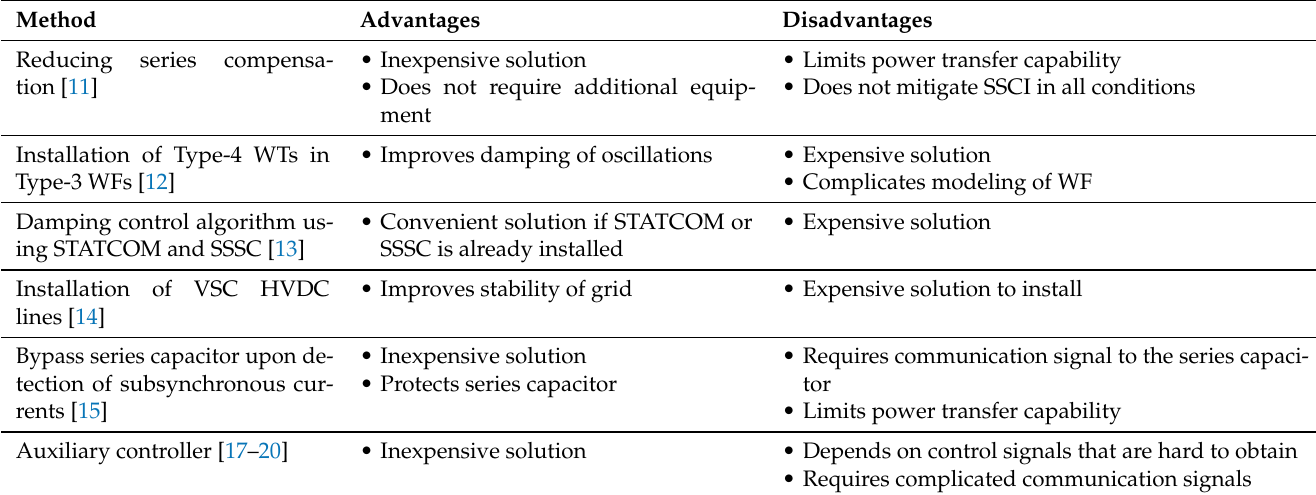
Table 1. Summary of mitigation methods for